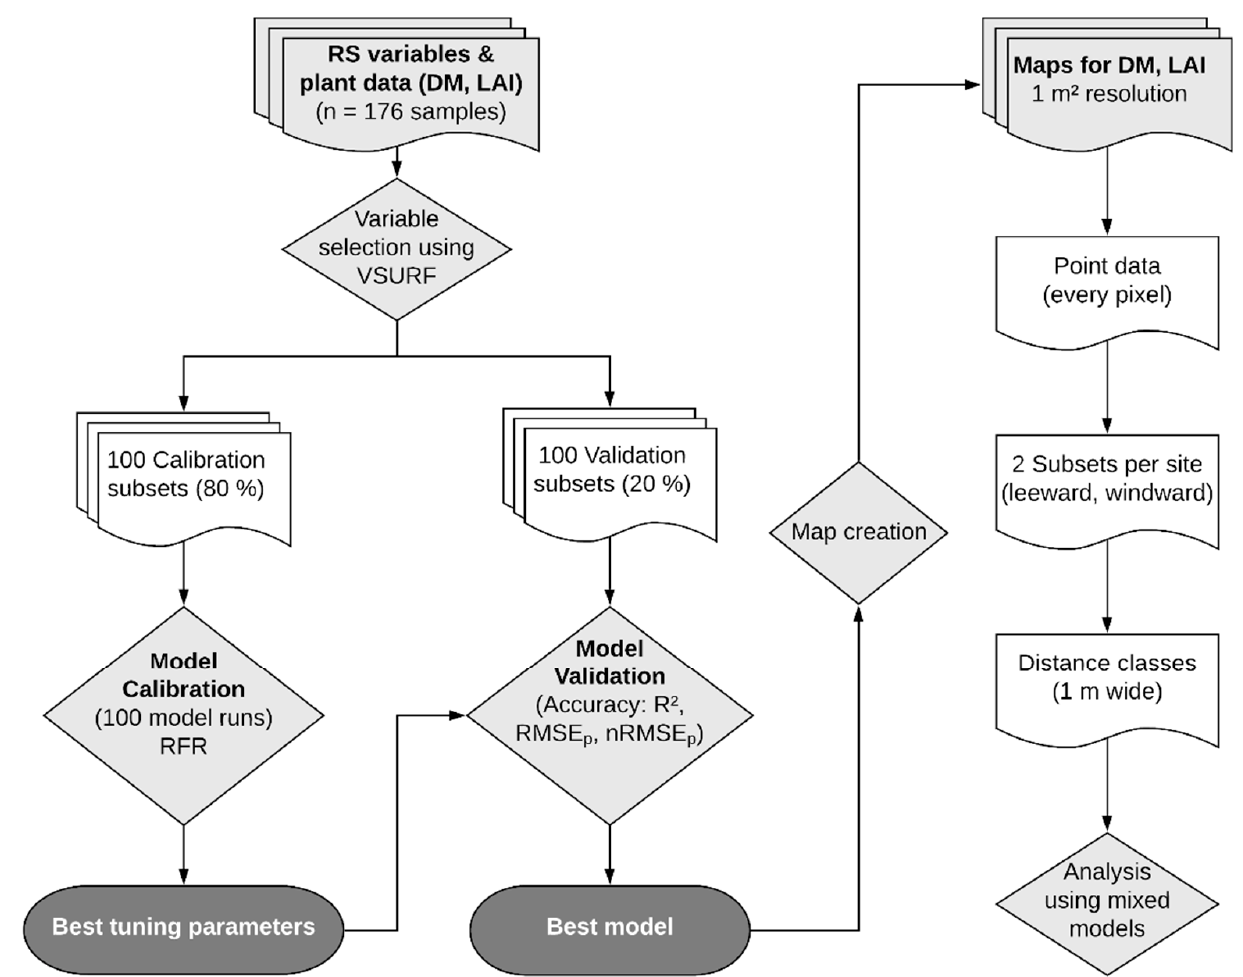
Figure 2. Workflow of model building, point data generation and spatial analysis.